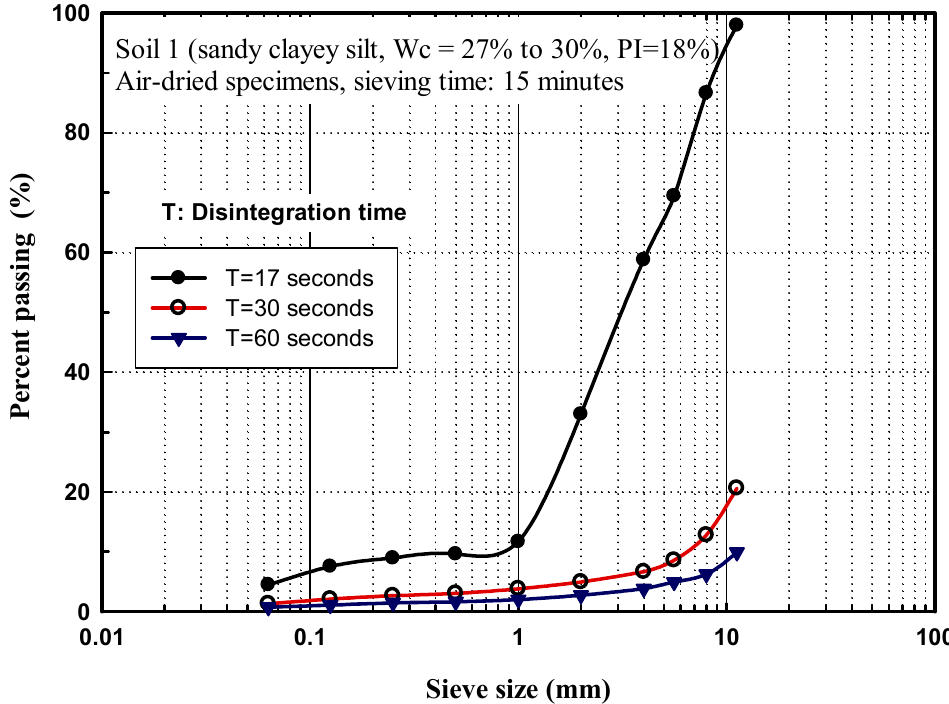
Figure 9. Percentage passing through versus sieve size for air-dried specimens of Soil 1 prepared at different disintegration times.